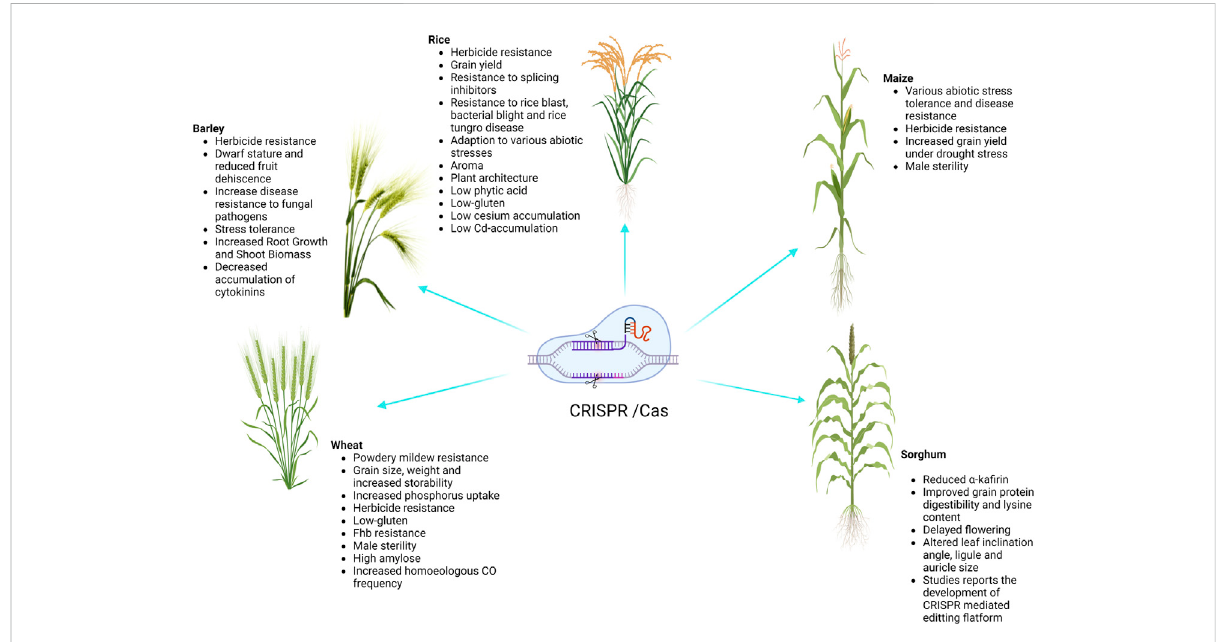
FIGURE 2 Successful application of CRISPR/Cas genome editing in